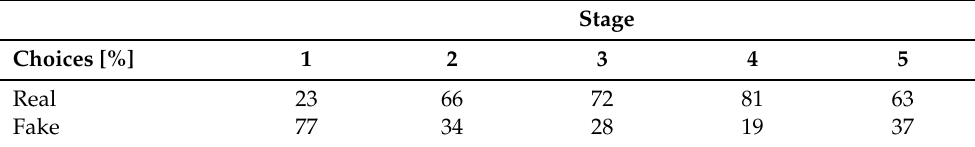
Table 3. Quantitative results of the MTurk-like multistage survey in %.